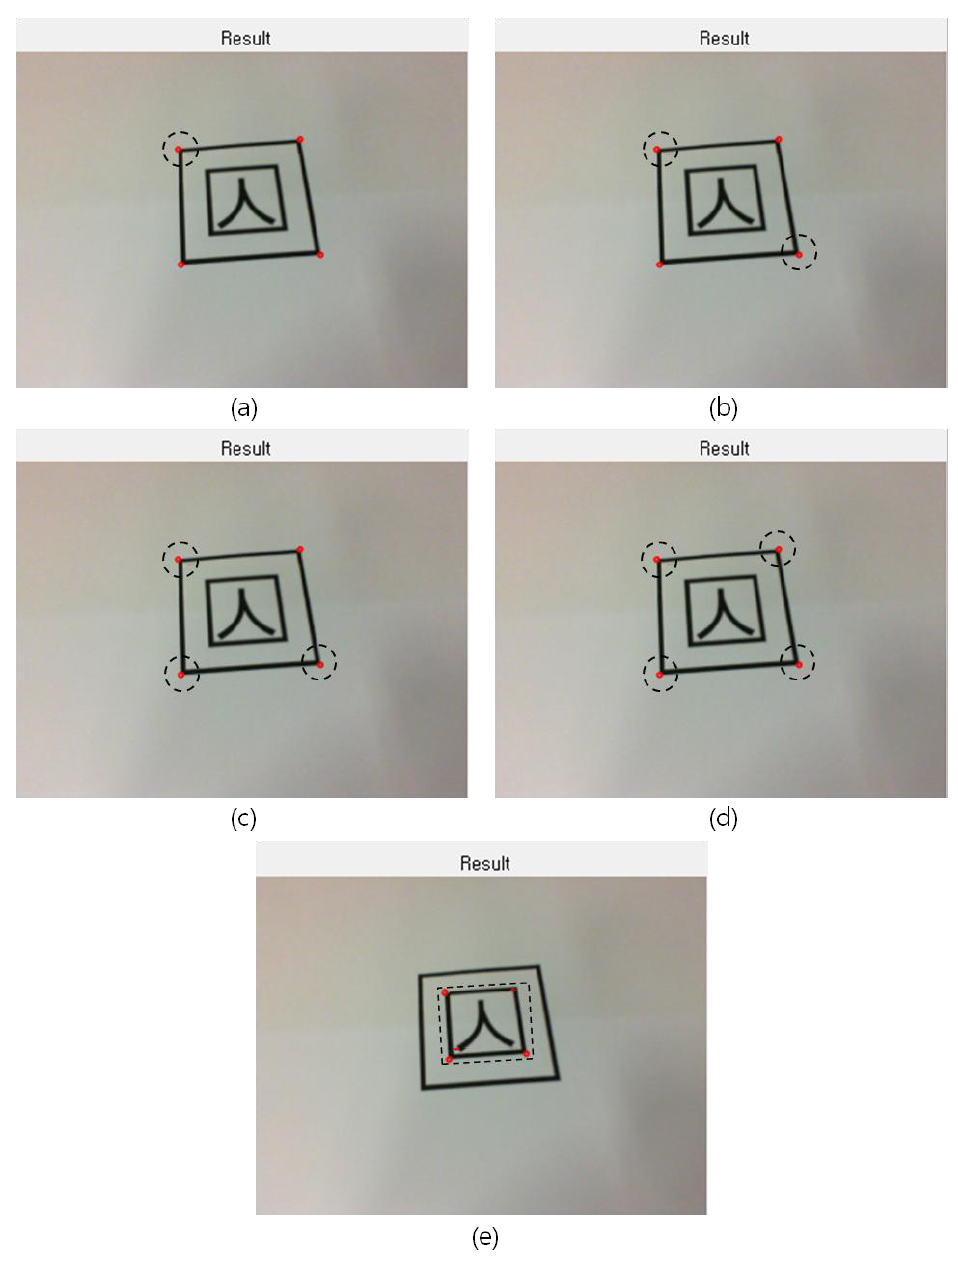
Figure 2. Edge points and detection of tag ROI. (a) Selected and an edge point locating farthest from the point is extracted by means of Pythagoras‟ theorem. (b) An edge point lying farthest from the extracted point is investigated. (c) An edge point locating farthest from the obtained edge point is extracted again. (d) A point which maximizes the area of the square becomes the rest one point. (e) The marker in marker tag can be extracted with edge